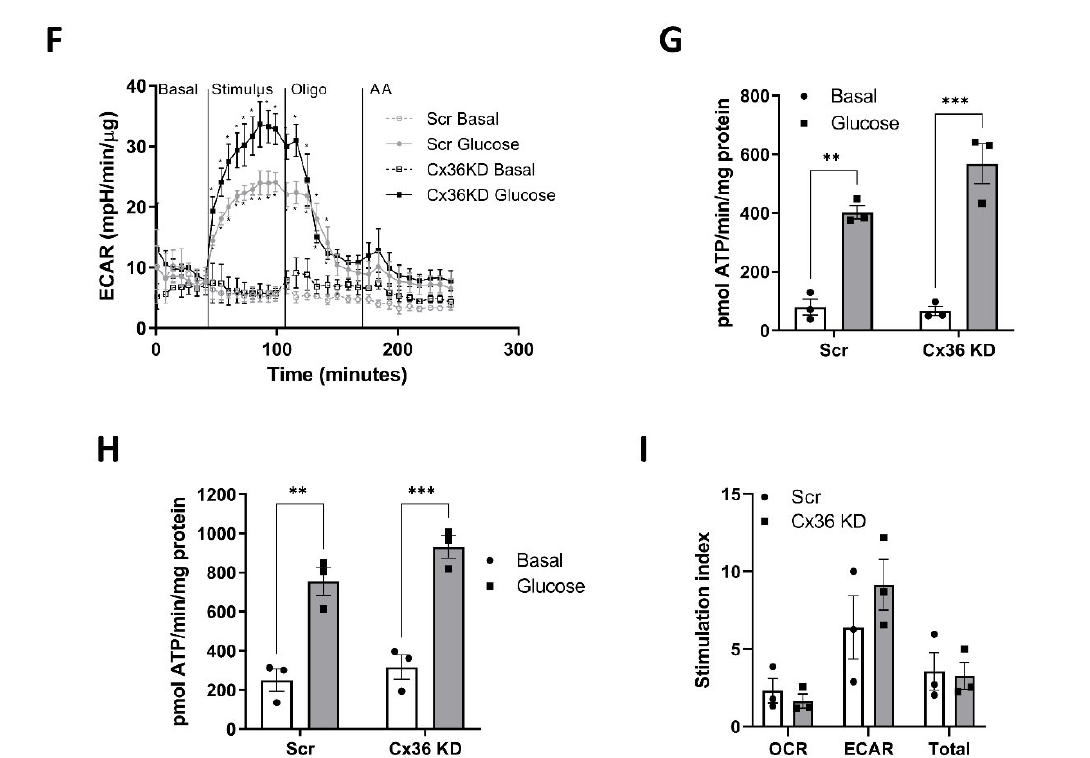
Figure 7. Connexin 36 does not significantly impact on GSIS or metabolic flux in pseudoislets. MIN6 cells expressing inducible scrambled shRNA (Scr) or shRNA against connexin 36 (Cx36 KD) were generated by transfection with lentiviral constructs followed by selection with 1 µ g/mL puromycin. Cells were cultured in un-coated Petri dishes to generate PI for 3 days prior to the addition of 1 µ g/mL doxycycline for a further 48 h to induce expression of shRNA constructs. ( A ) Protein expression of Cx36 was determined by Western blotting. Images are representative of 2 experiments ( B ) Insulin secretion at low (LG, 3–5 mM) or high (HG, 25 mM) glucose was determined in ML and PI for 1 h and expressed as fold change relative to Scr LG. ( C ) The stimulation index was calculated as the ratio of stimulated (HG) to basal insulin secretion (LG). ( D – I ) MIN6 PI were transferred to Seahorse islet capture plates for 24 h prior to measurement using the Seahorse XFe24 well analyser with additions of Glucose (25 mM), Oligomycin (20 µ M) or antimycin A (0.5 µ M) as indicated. ( D ) OCR expressed as pmol/min/ µ g protein. ( E ) ATP production from OCR expressed as pmol ATP/min/mg protein. ( F ) ECAR is expressed as mpH/min/ µ g protein. ( G ) ATP production from ECAR expressed as pmol ATP/min/mg protein. ( H ) Total ATP production from OCR and glycolysis expressed as pmol ATP/min/mg protein. ( I ) Stimulation index was calculated as the ratio of stimulated (glucose) to basal ATP production (basal). n = 3. ** p < 0.01, *** p < 0.005 using a 2-way ANOVA followed by Bonferroni post hoc